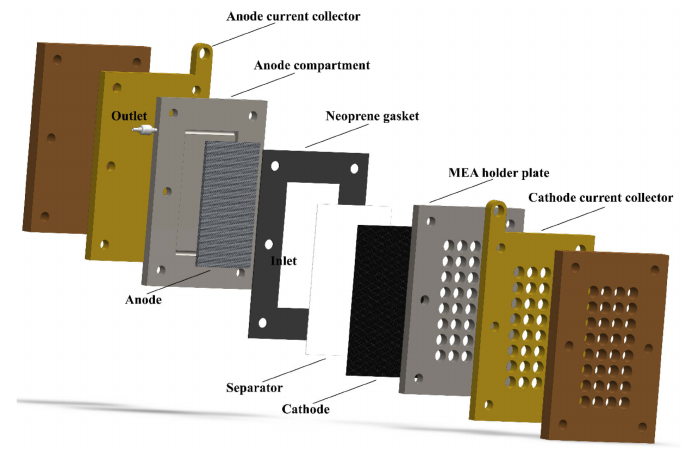
Figure 6. Exploded view of the passive air-breathing FPMFC configuration used in this